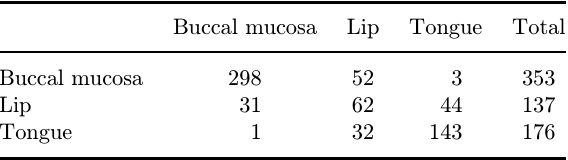
Table 3. PC-LDA for identifying anatomical di®erences at buccal mucosa, lip and tongue subsites in contralateral conditions.